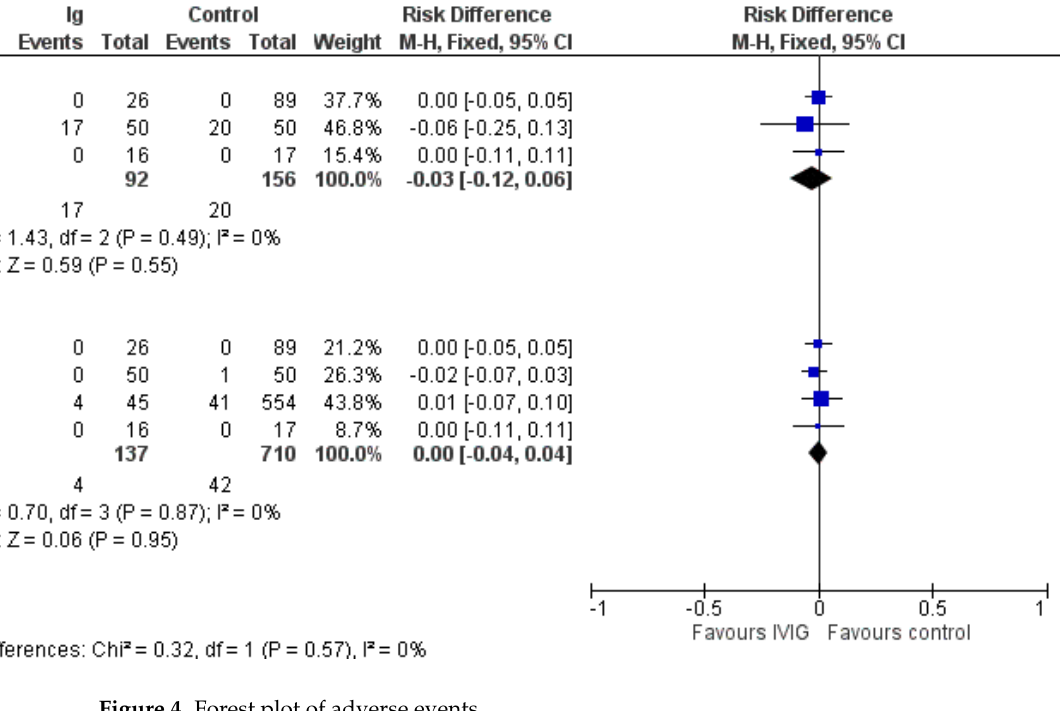
Figure 4. Forest plot of adverse events.